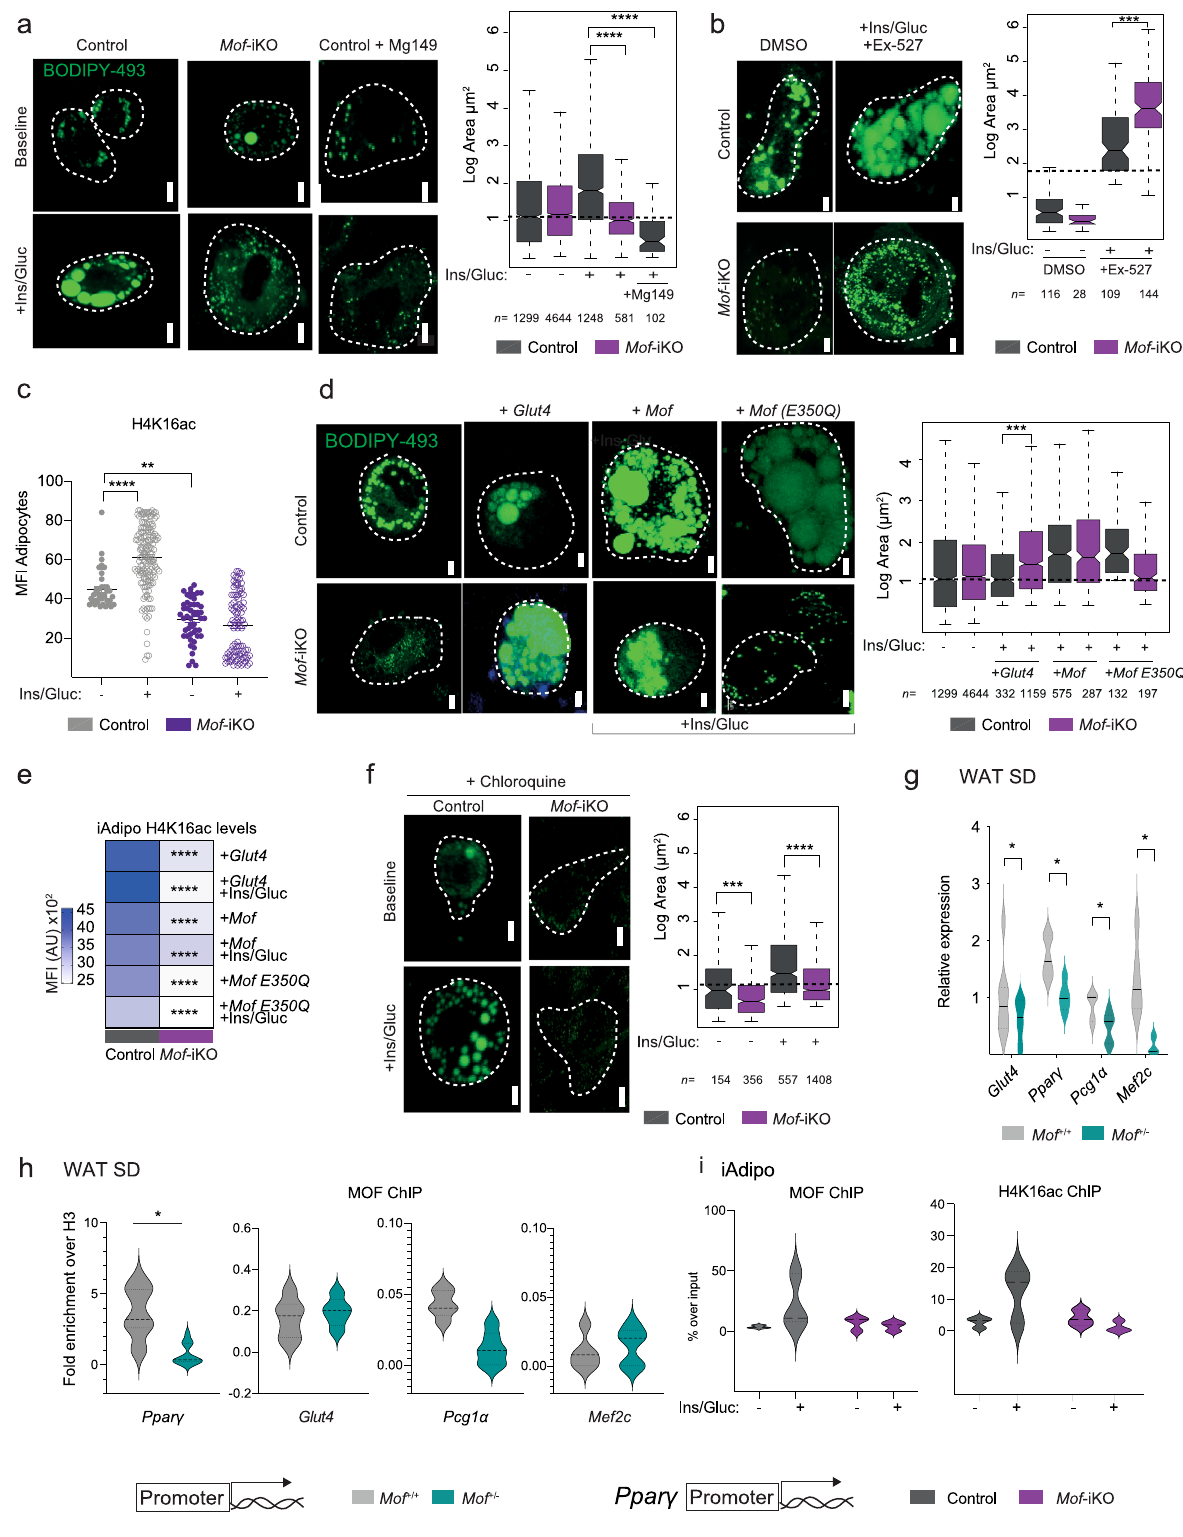
as WAT or SKM, triggering expression and translocation of GLUT4 to boost glucose uptake and reduce extracellular glucose levels. Insulin release is transient and ceases immediately once basal glucose levels are reinstated. We propose a model in which insulin secretion in Mof + / − animals is not completely blocked,